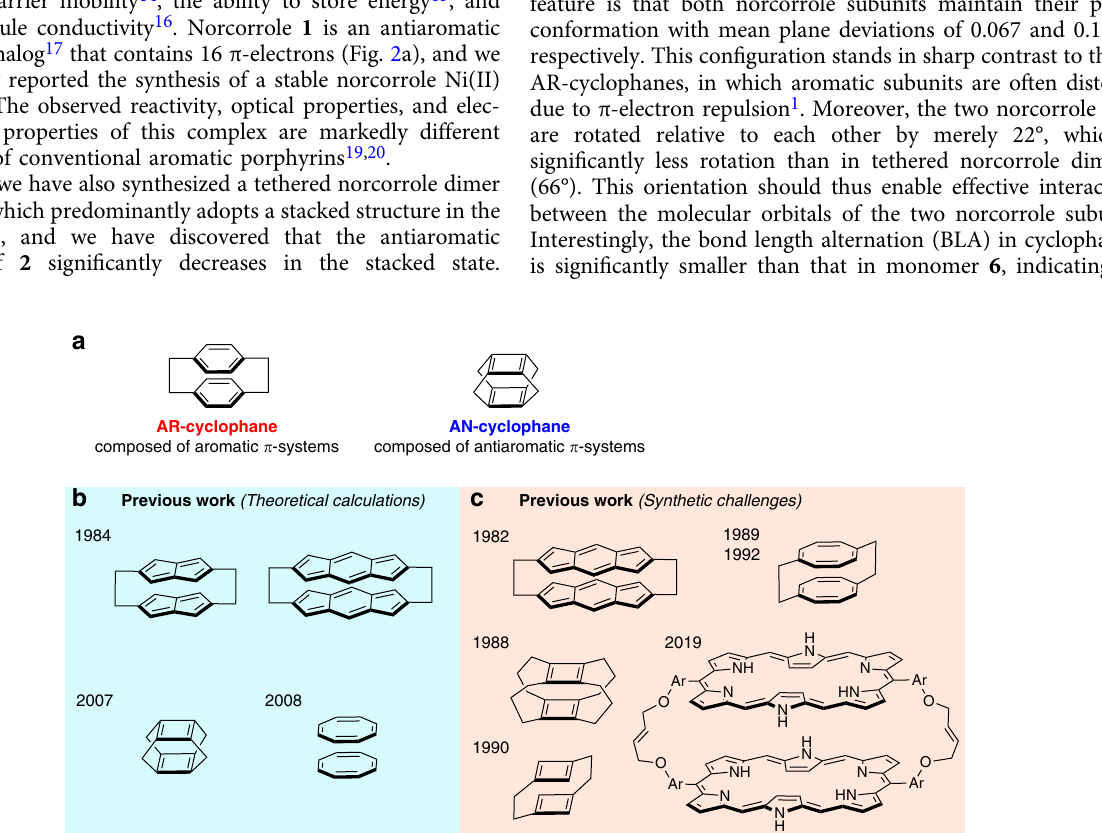
Fig. 1 Cyclophanes. a Representative examples of aromatic cyclophanes (AR-cyclophanes) and antiaromatic cyclophanes (AN-cyclophanes). b Theoretical studies on AN-cyclophanes. c Attempted unsuccessful syntheses of